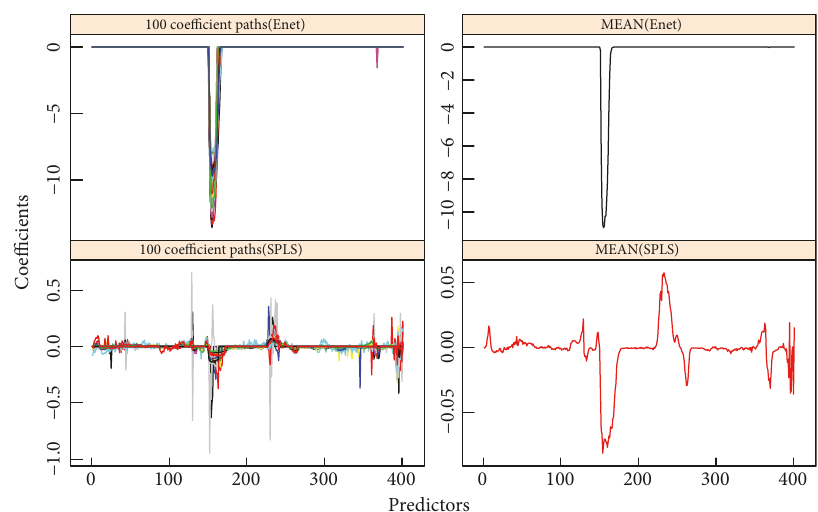
Figure 8: Coefficients paths of gasoline by replicating 100 times. The left subgraphs are the coefficient paths by Enet and SPLS based on 100 replications, and the right subgraphs are the mean of coefficients by the two methods.